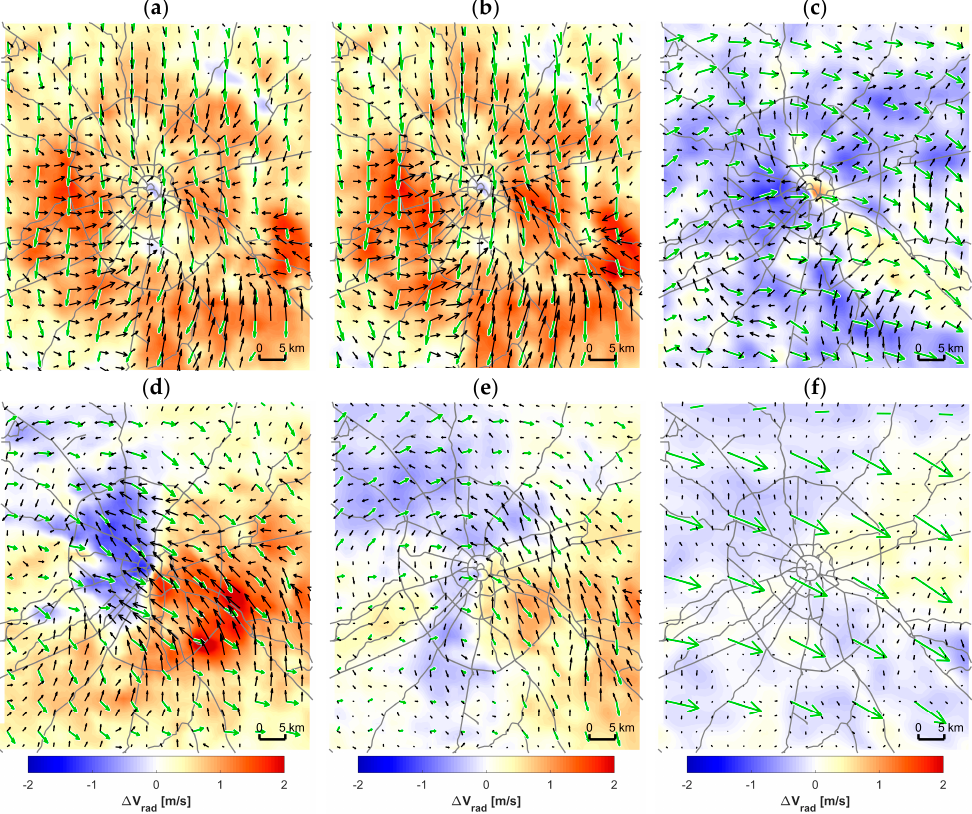
Figure 10. The vector field of the modeled wind response to switching on the urban canopy model ( ∆ V , shown by black arrows) and response of the radial wind speed component ( ∆ V rad , shown by color) at: 2nd ( a , d ); 4th ( b , f ); and 16th ( c , e ) model levels with corresponding heights above the surface equal to 34 m, 120 m and ≈ 1.7 km, averaged over selection of: evening (15–16 UTC/18–19 MSK) ( a – c ); and nocturnal (0–1 UTC/3–4 MSK) ( d – f ) cases with low background wind speed, sampled out from the selection of days with intensive urban heat island during June–August 2014. Green arrows represent wind speed and direction at corresponding model levels according to “noURB” simulations, and the scale is similar to black